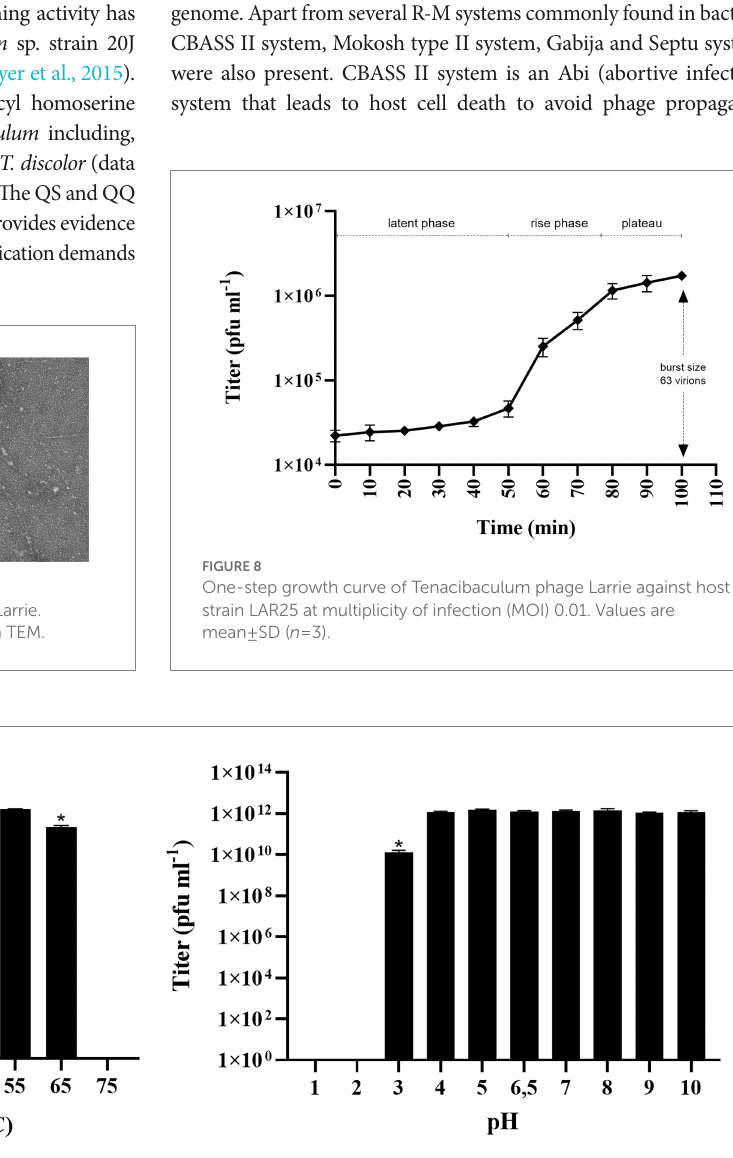
FIGURE 7 Effect of different temperatures and different pH on the stability of Tenacibaculum phage Larrie. Values are mean ± SD ( n = 3) while (*) indicates statistically significant differences between different treatments ( p <